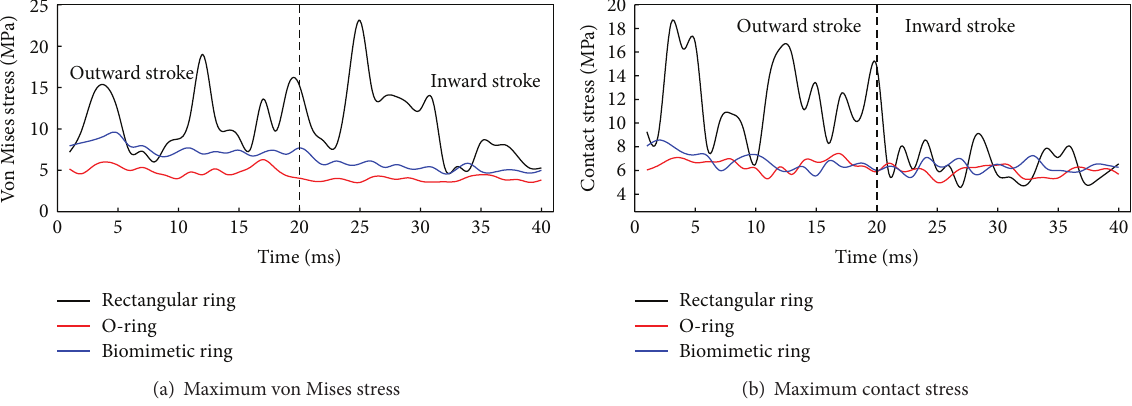
Figure 14: Stress of sealing rings in reciprocating dynamic seal.